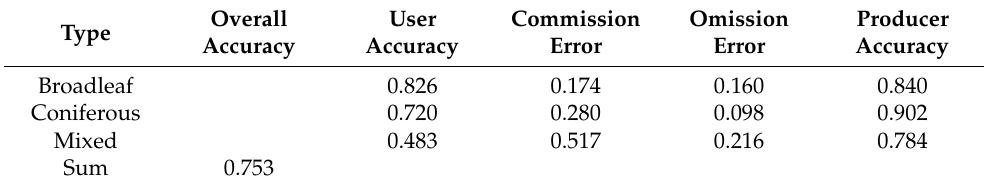
Table 9. Accuracy evaluation matrix of integration results based on Model I.